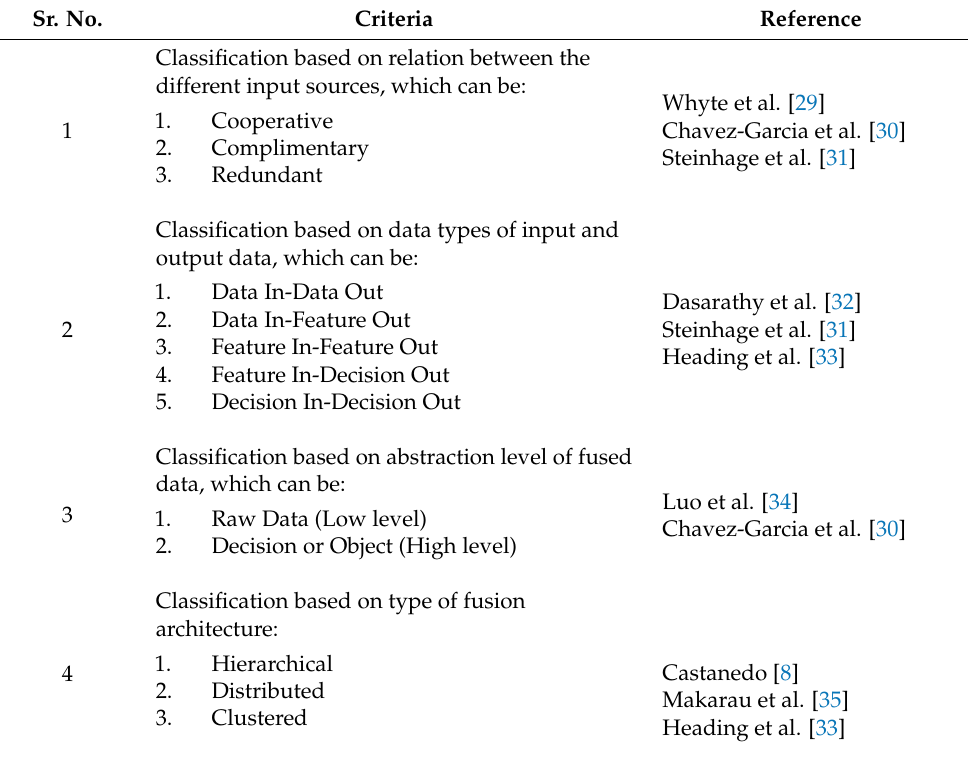
Table 1. Classification of sensor fusion